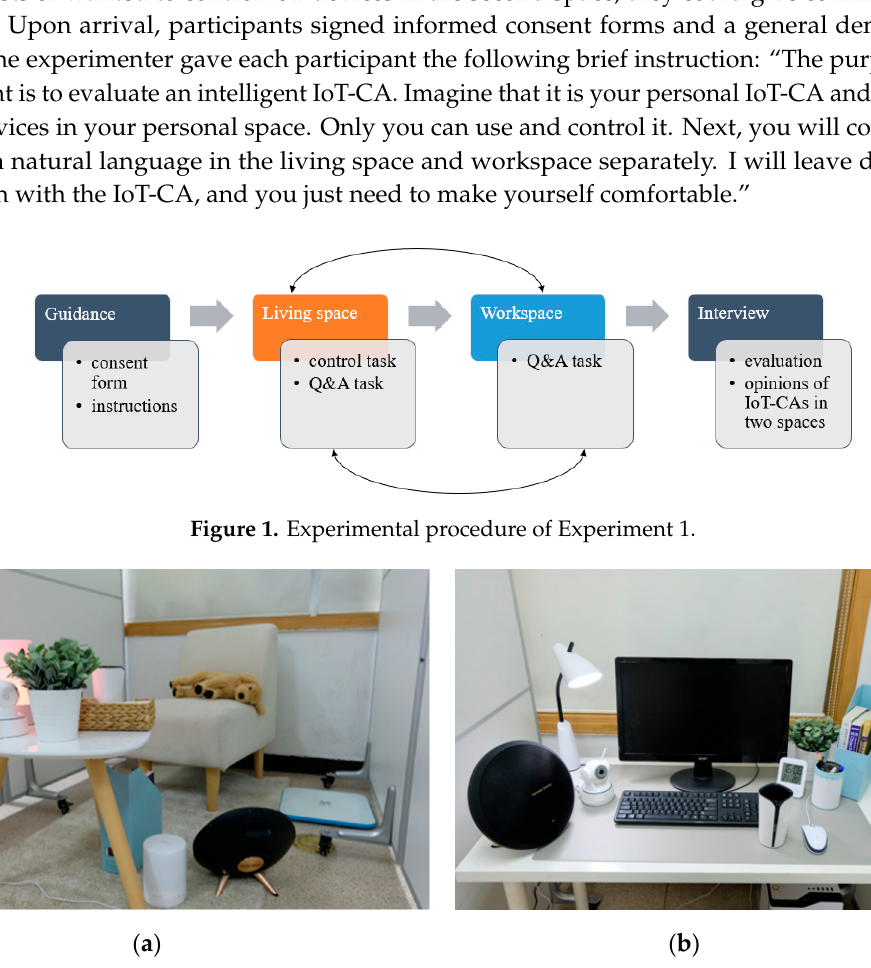
Figure 2. Experimental spaces in Experiment 1: ( a ) living space and ( b ) workspace.